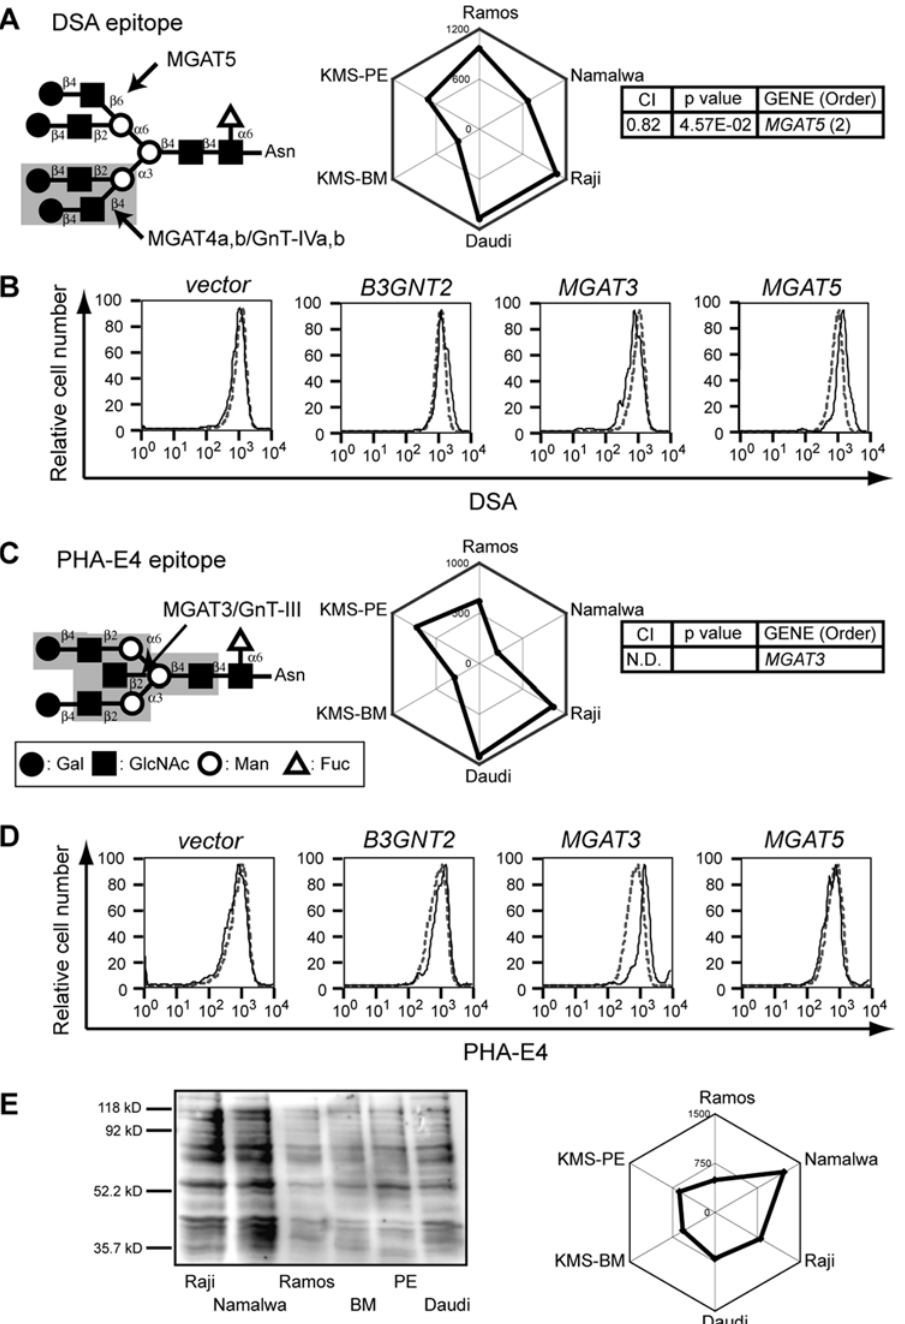
Figure 4. CIRES analyses of staining profiles obtained using lectins that recognize internal glycan structures and have unknown epitope- expression-regulating enzymes. Presentation is the same as in Fig. 2 except that the plant lectins used were (A, B) DSA and (C–E) PHA-E4. N.D. in the gene order list indicates that no significant correlation was detected. (B, D) Flow cytometric staining patterns for EGFP-positive Namalwa cells are shown in bold lines, and those for EGFP-negative (control) cells are shown in gray dashed lines. The overexpression of MGAT5 resulted in a subtle (60%) increase in DSA staining. The overexpression of MGAT3 resulted in a 2-fold increase in PHA-E4 staining. (E) PHA-E4 lectin blotting was performed using the membrane fraction of the same set of cell lines. A plot of the quantified signals reveals differences in the PHA-E4 staining profile among the six cell lines (C, E), as discussed in the text.